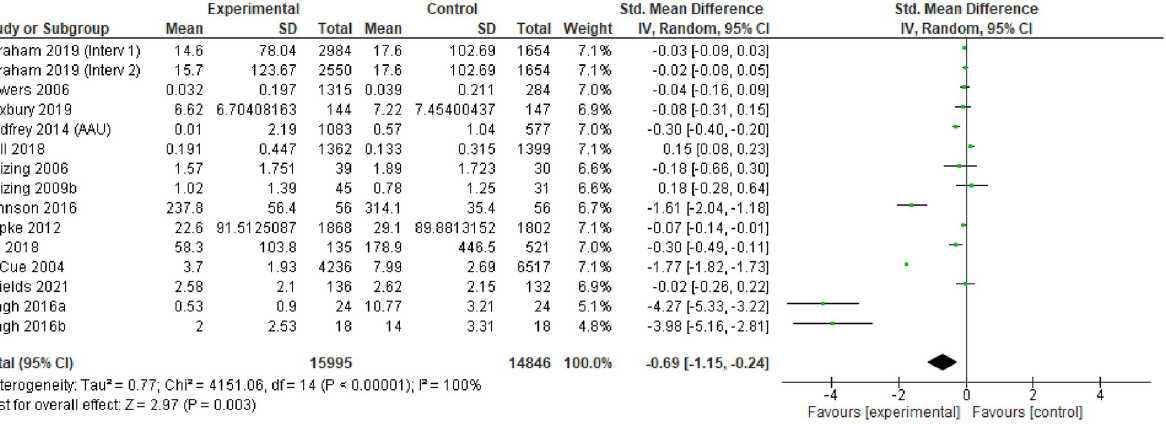
Fig 3. Effectiveness of interventions on the use of restraint: All included studies.